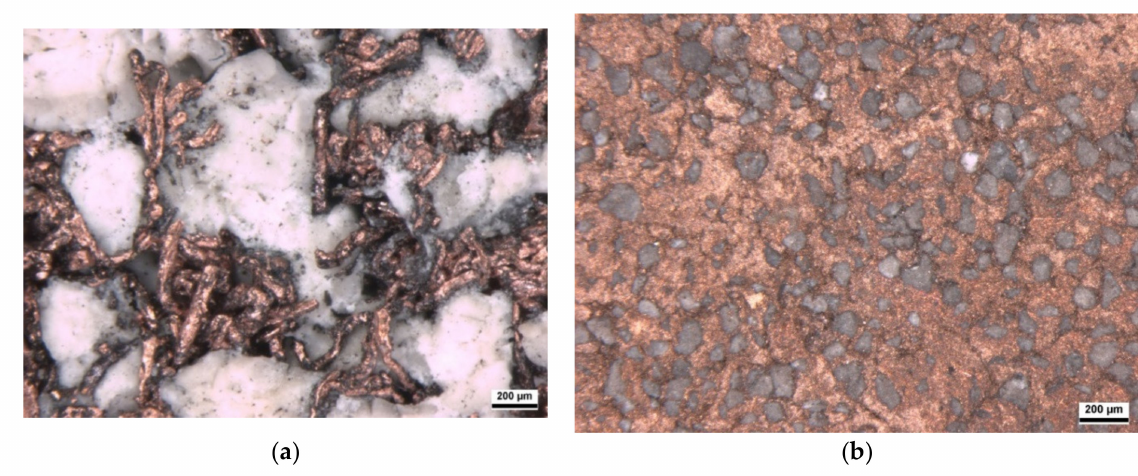
Figure 1. Surface structure of Cu-zeolite composites after sintering, ( a ) sample we55, ( b ) sample we95.